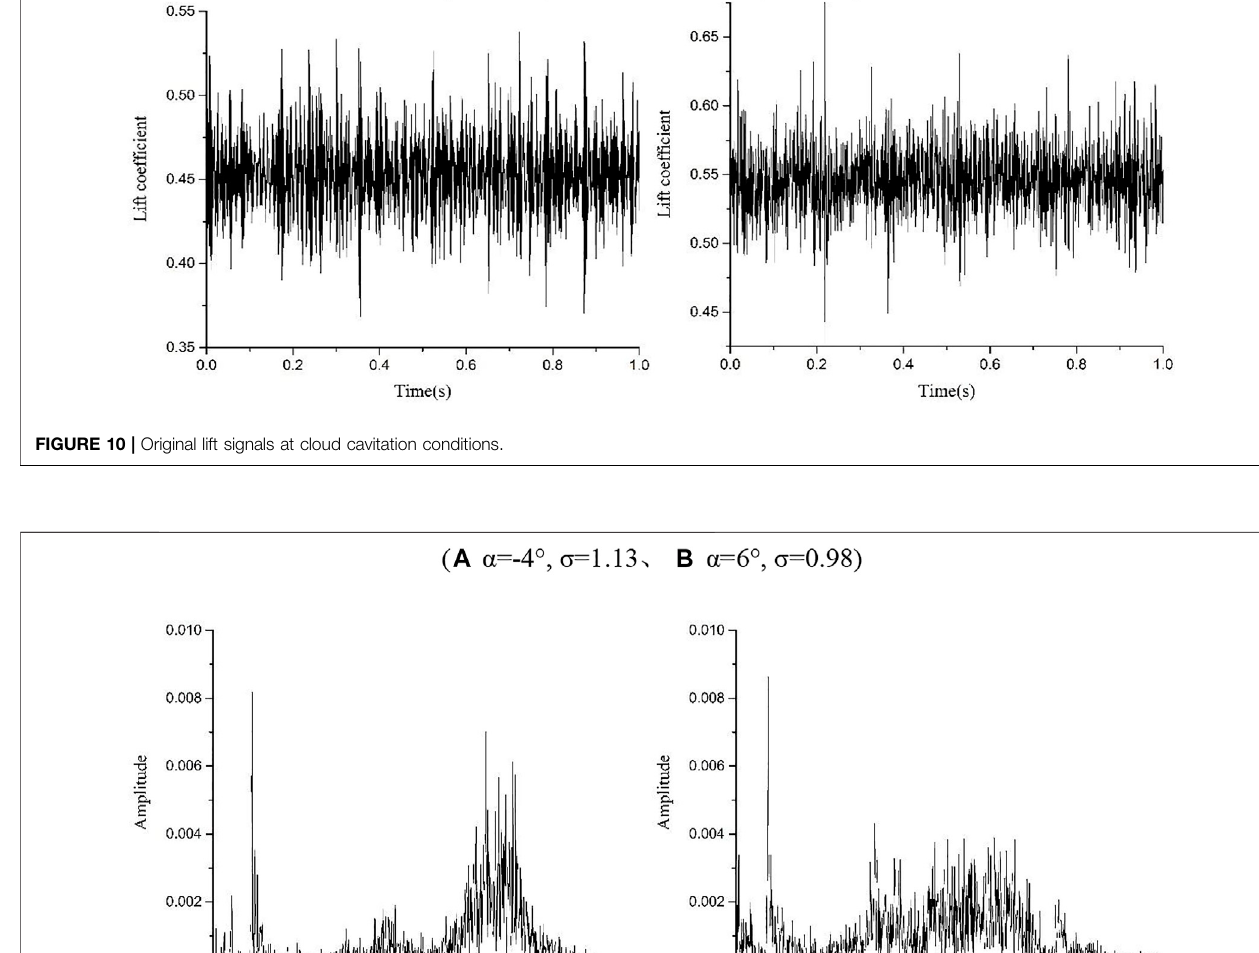
Frontiers in Energy Research |